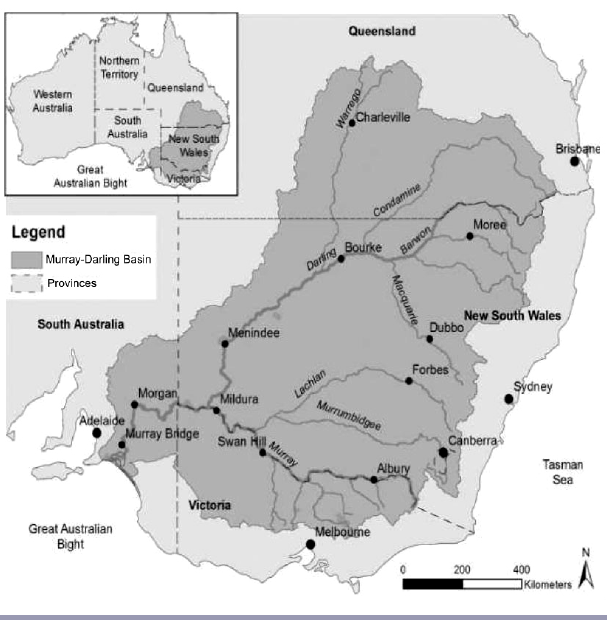
Fig. 1 . The Murray-Darling